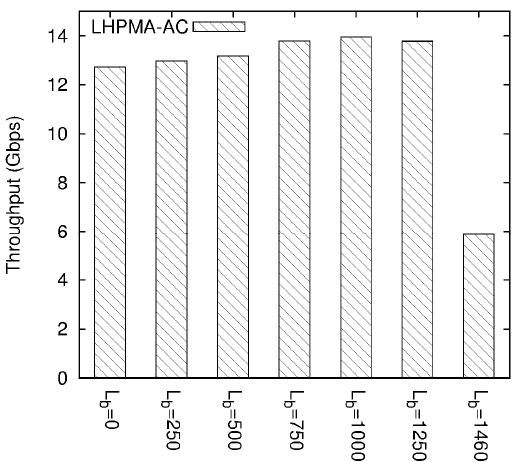
Figure 6. The performance of GPU processing with different lengths of input payloads.